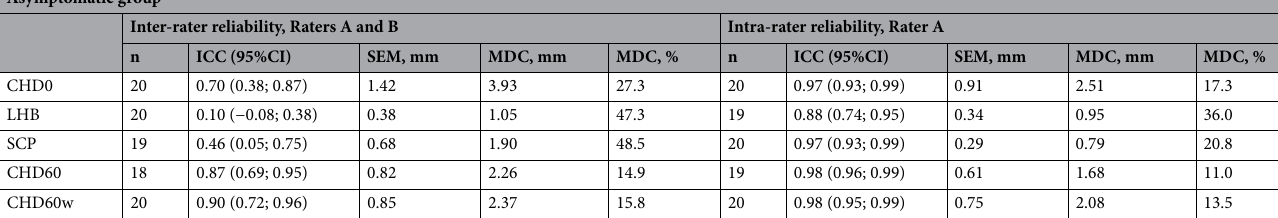
Table 2. Inter and intra rater reliability in the asymptomatic group. 95%CI 95% confidence interval, CHD0 coracohumeral distance at rest, CHD60 coracohumeral distance at 60°, CHD60w coracohumeral distance at 60° with weights, LHB long head of biceps tendon, MDC minimal detectable change at 95% of confidence interval, MDC% minimal detectable change in % respect to mean value of raters A and B or to three mean values of rater A, n number of participants considered in the statistical analysis, SCP subscapularis tendon, SEM standard error of measurement.